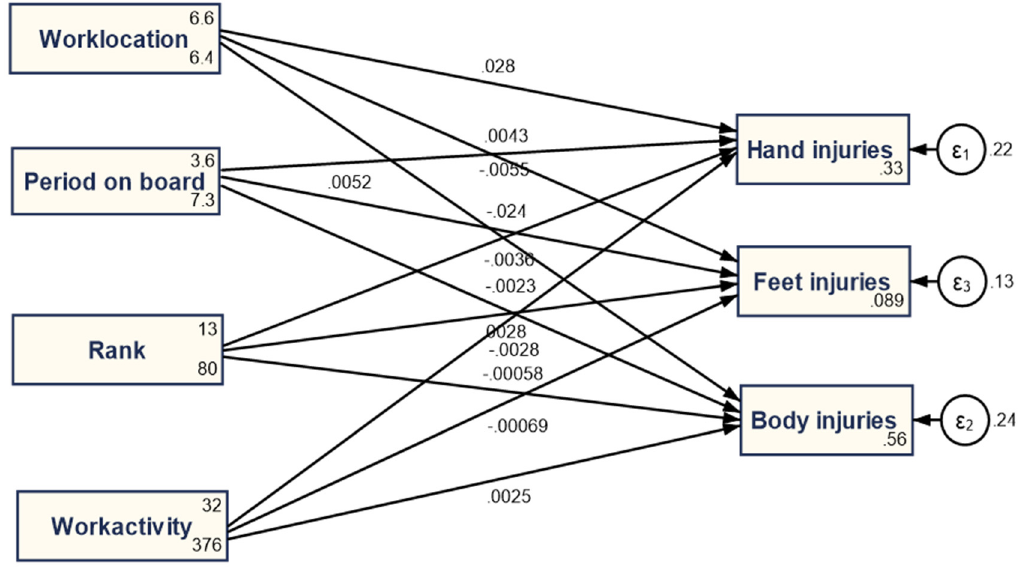
Figure 7. SEM 3, third model of structural equation modeling. Source: Own data process in Stata. Table 6. Detailed results of SEM 3—third model of structural equation modeling.